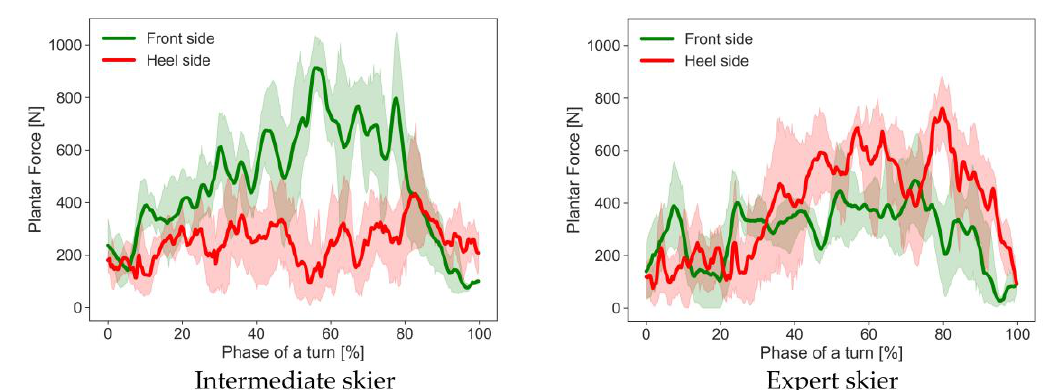
Figure 8. The right plantar force for the front and heel side during the left turn. The ( left pane ) is for the intermediate skier and the ( right pane ) is for the expert skier. The green line is for the front side and the red line is for the heel side.